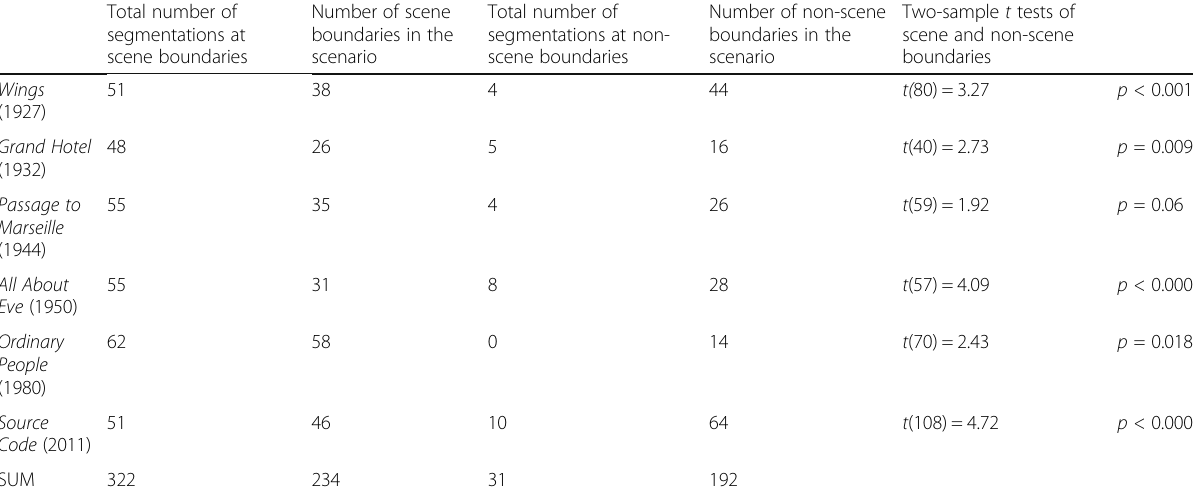
Two-sample t tests of scene and